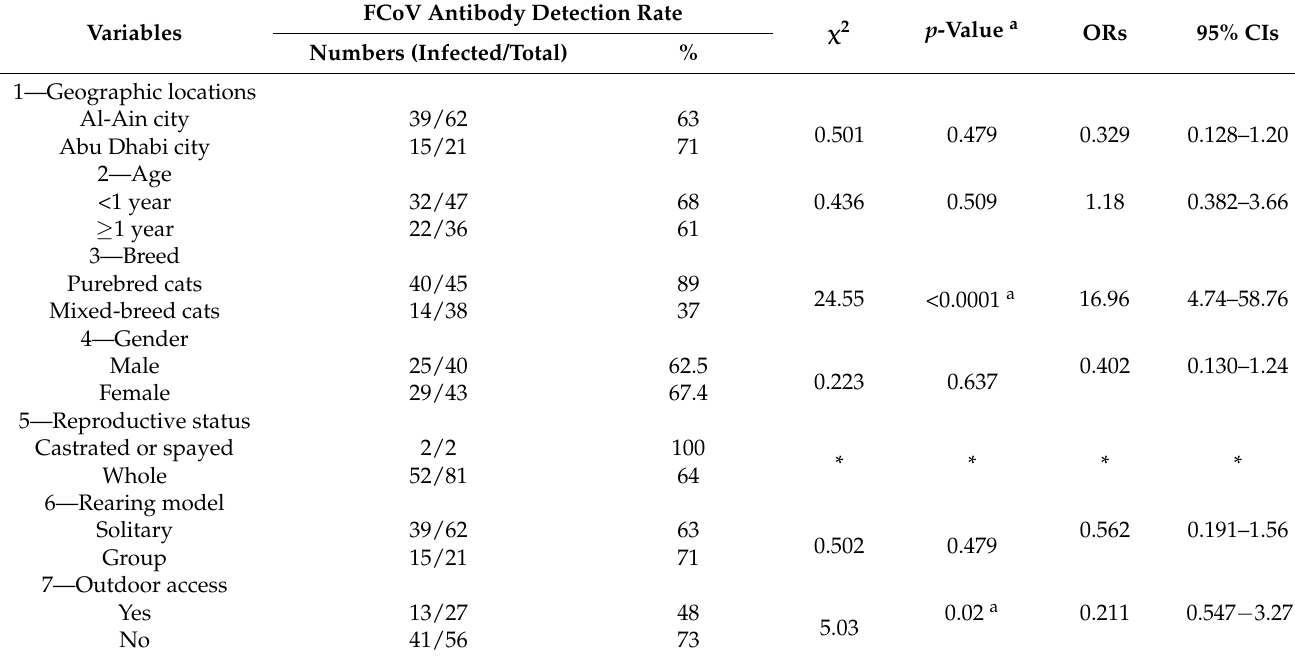
Table 2. Prevalence of FCoV infection and analysis of risk factors in cats ( n =